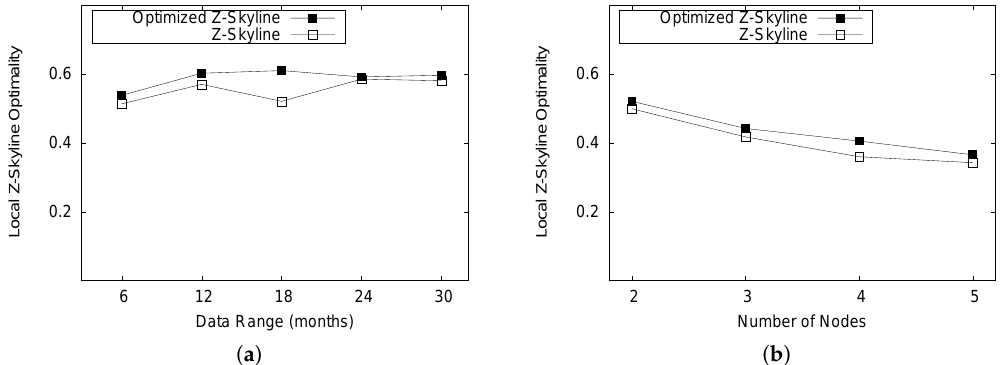
Figure 29. Z-Skyline Optimality. ( a ) Varying the data size; ( b ) Varying the number of